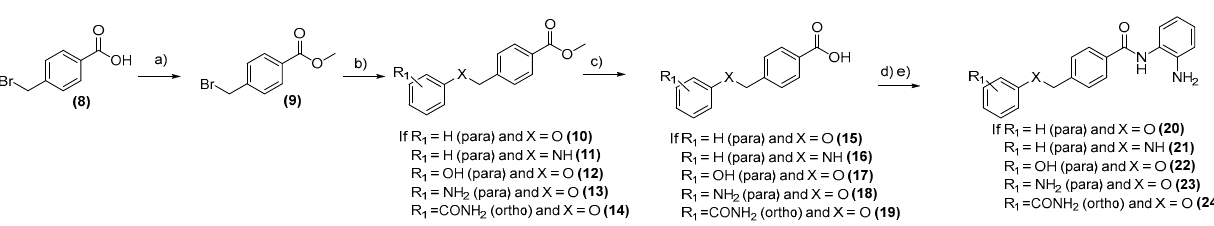
Figure 8. Synthesis of compounds ( 4 ), ( 5 ), and ( 7 ).